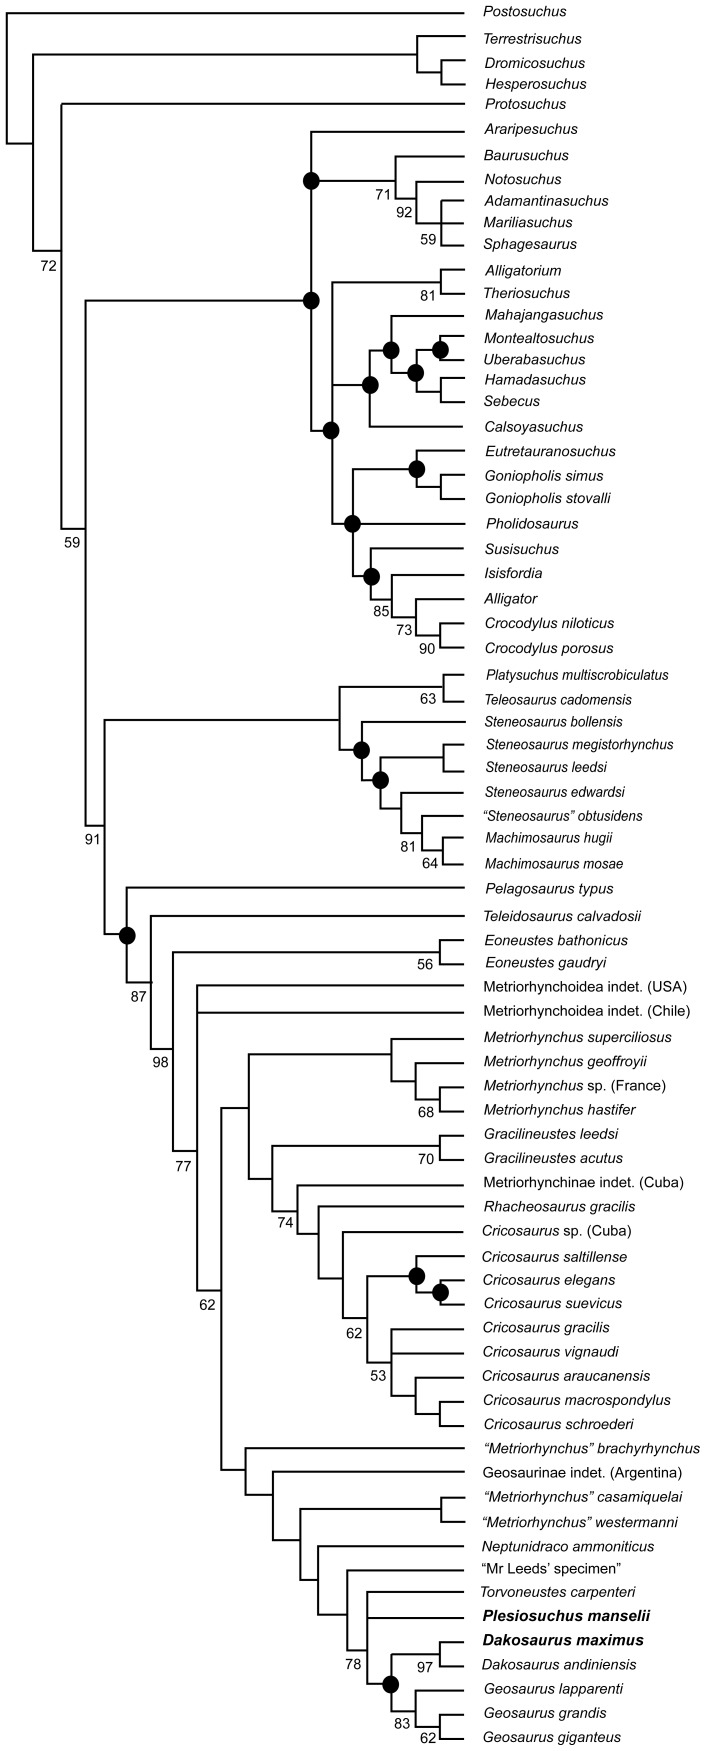
50% majority rule consensus topology of 195 most parsimonious cladograms, showing the phylogenetic relationships of Plesiosuchus manselii and Dakosaurus maximus within Metriorhynchidae when 40 characters are ordered.Length = 667; ensemble consistency index, CI = 0. 481; ensemble retention index, RI = 0. 863; rescaled consistency index, RC = 0. 415. The black circles at certain nodes denote clades that break in the strict consensus topology. Bootstrap-values are given above or below the relevant node.